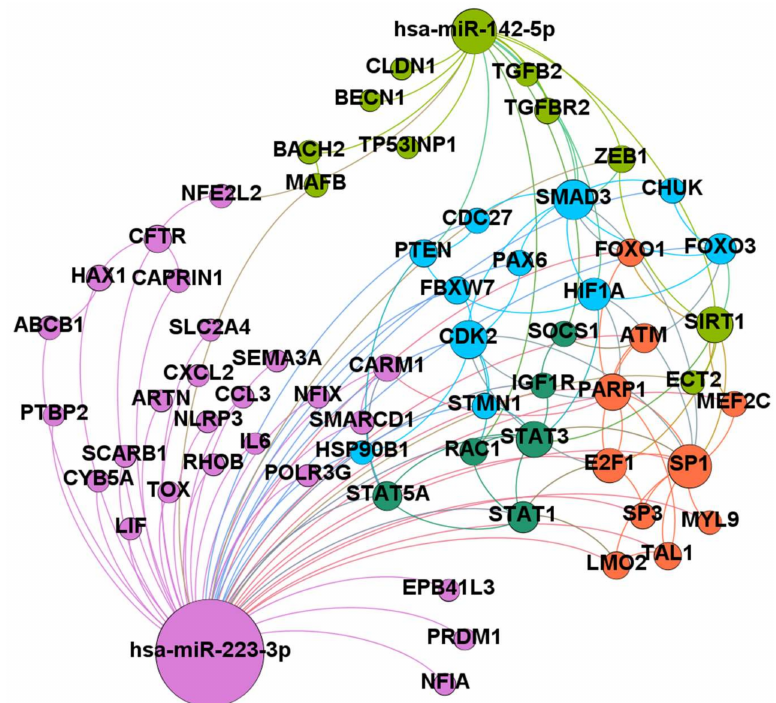
Figure 4. miRNA–protein network. The overall connectivity of miR-223-3p and miR-142-5p was examined by assembling miRNA–mRNA associations and protein–protein interactions. The size of the nodes is proportional to degree centrality. The five modules found are colored in purple, blue, orange, light-green, and dark-green